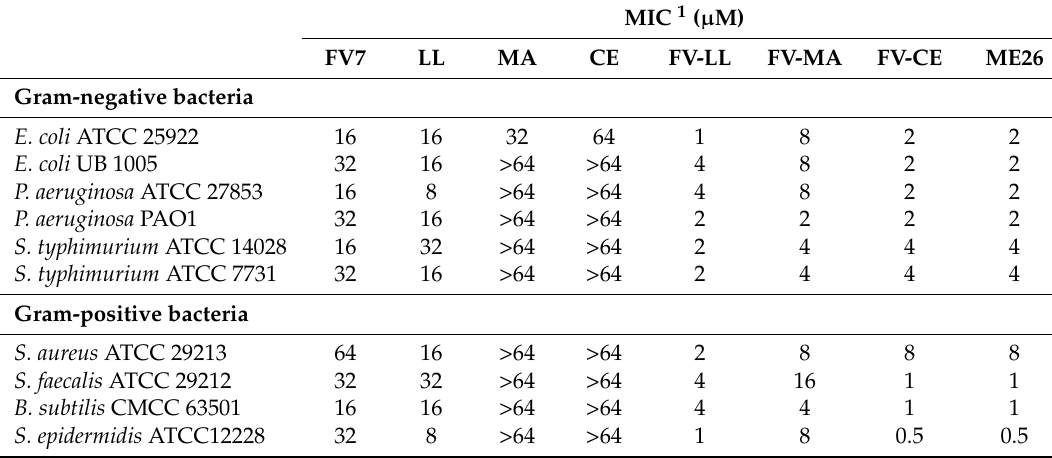
Table 2. Antibacterial activities of the peptides.